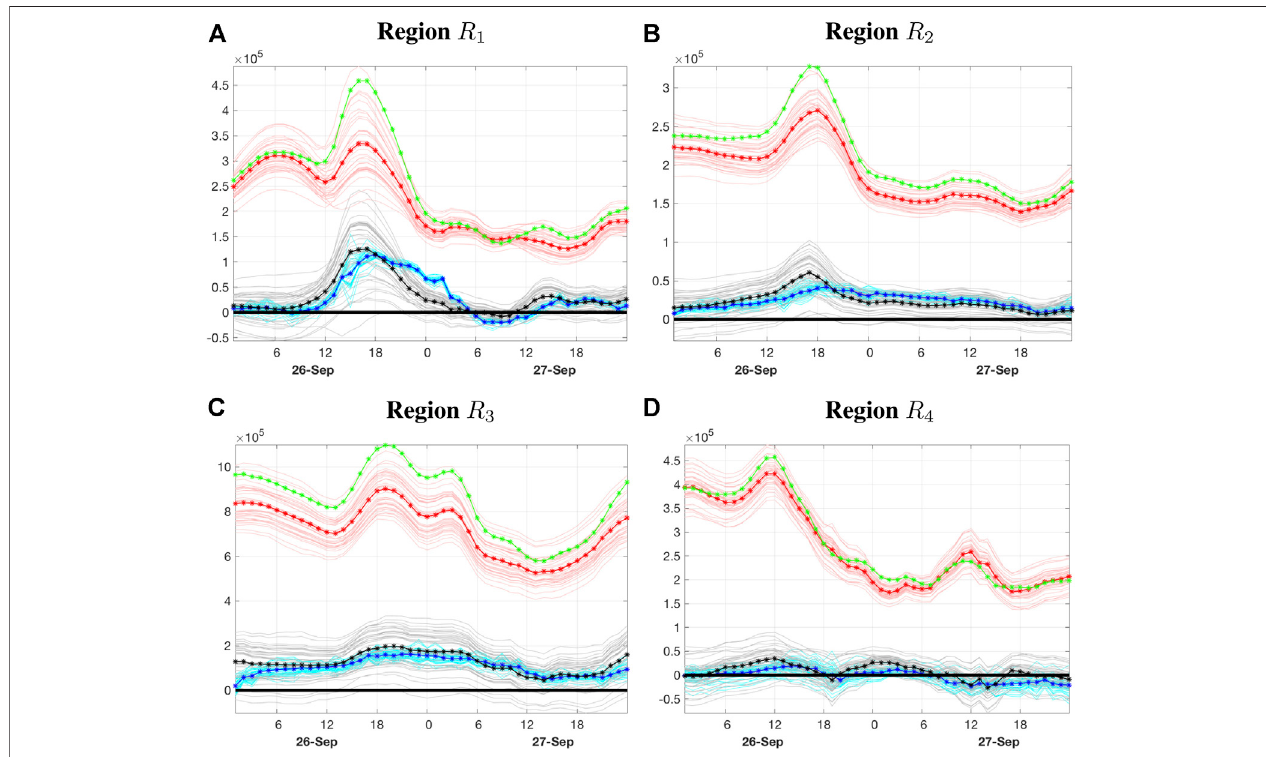
FIGURE 3 | (A) Time series of the true electron density (green), in units of el / cm 3 , averaged over region R 1 (as de fi ned in Figure 2A ), at the indicated altitudes. The electron density, averaged over the same region, for the background ensemble (pink) and its ensemble mean (red) are also shown. The deviation of the background ensemble and its ensemble mean from the truth are given by the thin gray and thick black curves, respectively. The time series of the ensemble of bias parameters and theirensemblemeanareshownbythethincyanandthethickbluecurves,respectively.Thehorizontalaxisistimeinhours,startingat00:30UTConSeptember26, 2011 and ending at 23:30 UTC on September 27, 2011. (B – D) Analogous time series of electron density, averaged over region R 2 (Northern polar region), region R 3 (daytime mid-latitudes), and region R 4 (night-time mid-latitudes),